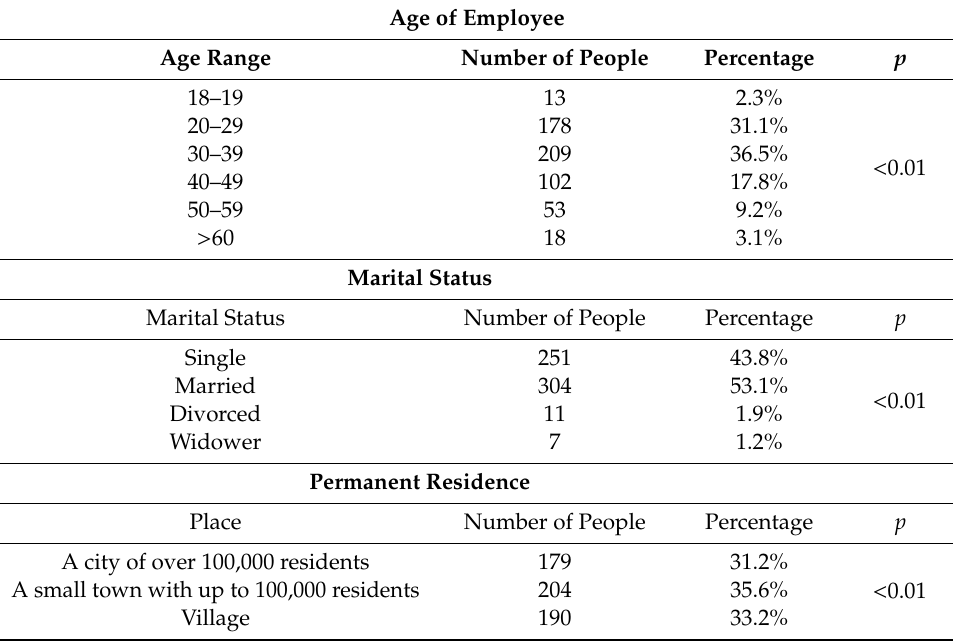
Figure 9. Example of façade scaffold with an area of 900-1500 m 2 (authors’ archive). Table 3 presents the obtained socio-demographic information on the respondents. Table 3. Socio-demographic information (own elaboration).